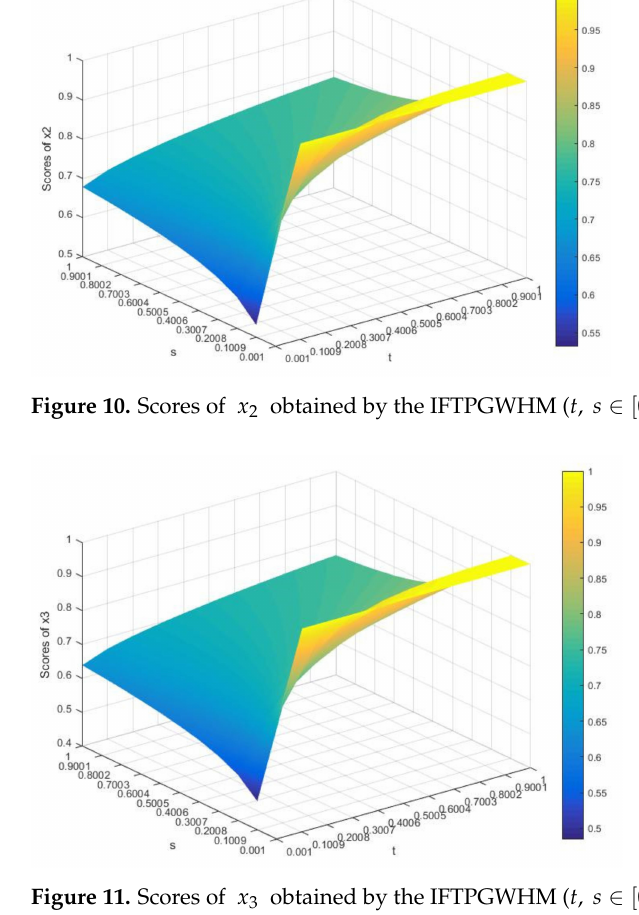
Figure 11. Scores of x 3 obtained by the IFTPGWHM ( t , s ∈ [ 0.001,1 ]